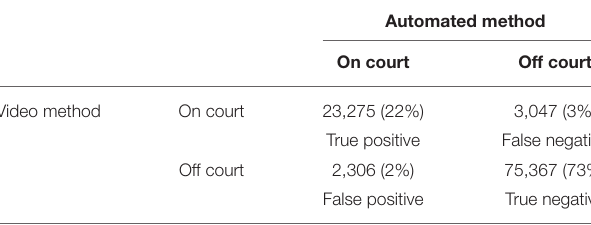
TABLE 2 | Classification of match activity confusion